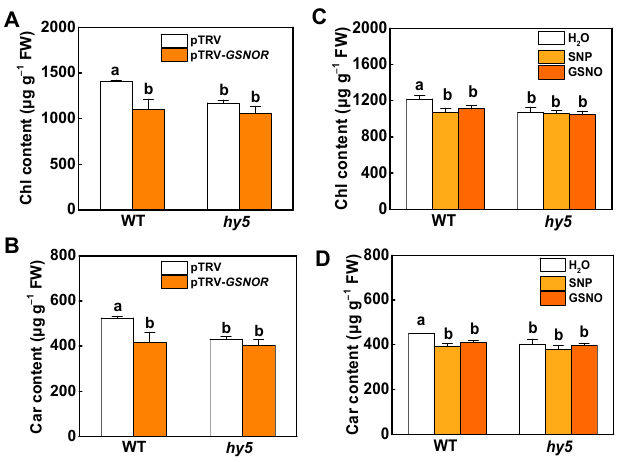
Figure 6. HY5 operates downstream of NO to modulate plant photosynthetic pigment biosynthesis. ( A , B ) Chlorophyll and carotenoid content of leaves in WT and hy5 in which GSNOR was silenced by means of the VIGS technique. ( C , D ) Chlorophyll and carotenoid content of leaves in WT and hy5 , 5 days after being treated with H 2 O, SNP, and GSNO. Data are shown as means ± SD ( n = 3). Different letters indicate significant differences at p < 0.05 according to Tukey’s test.